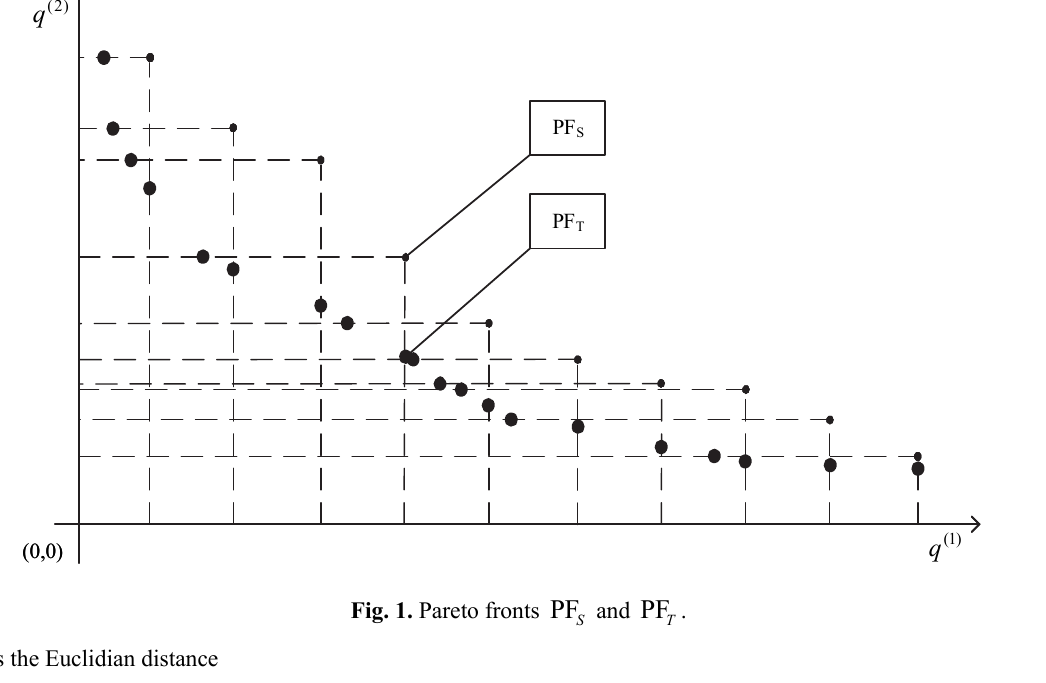
Fig. 1. Pareto fronts PF